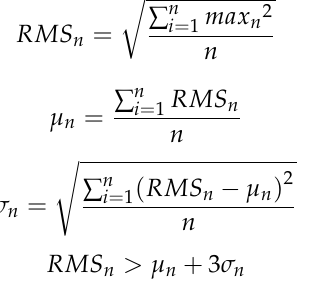
Table 1. Feature extraction of rolling bearing vibration signals.